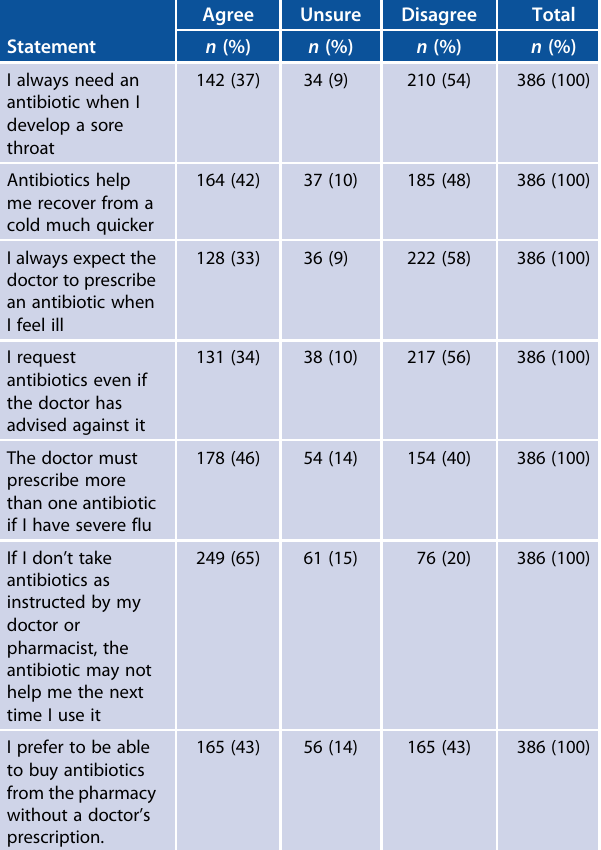
Table 4: Patients ’ attitudes towards antibiotic use at Prince Mshiyeni Memorial Hospital 2017